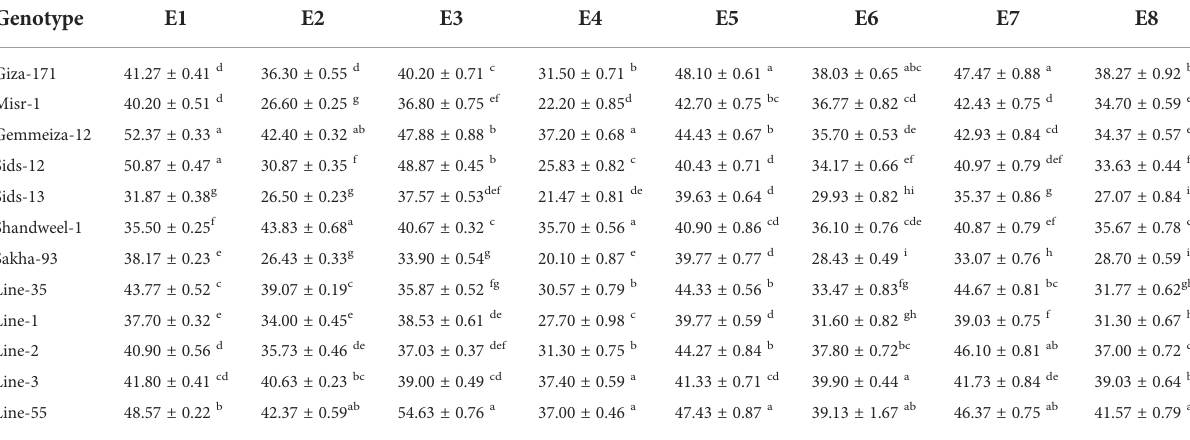
TABLE 7 Thousand-grain weight (g) for twelve bread wheat genotypes in two locations (Kafer El-Hamam and Sakha) during two growing seasons in 2015-2016 and 2016-2017 under timely and late sowing dates. Genotype